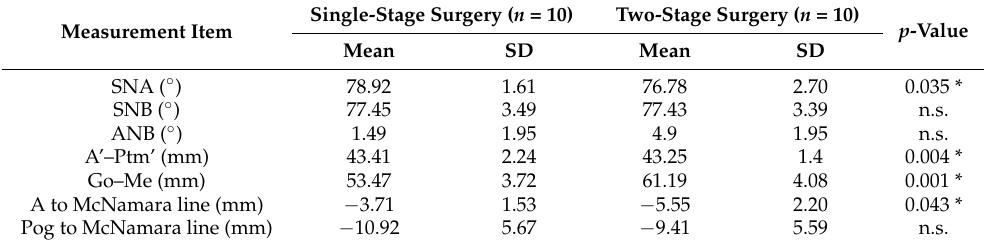
Table 1. Cephalometric analysis results.